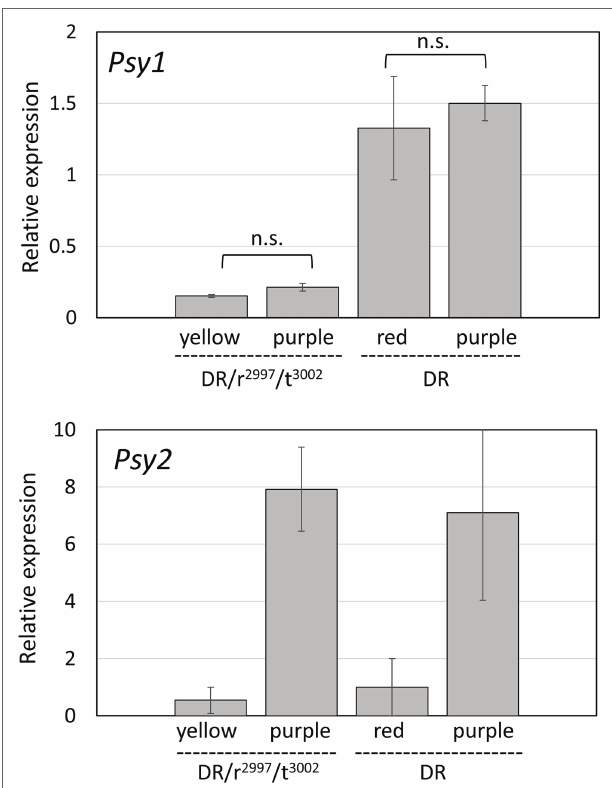
FIGURE 7 | Transcript levels of PSY1 and PSY2 in silenced and non- silenced sectors dissected from VIGS-treated fruits of the DR / r 2997 / t 3002 and DR (control) plants. The data were compared using the “Compare all pairs” (Tukey–Kramer), p < 0.05. n.s. no